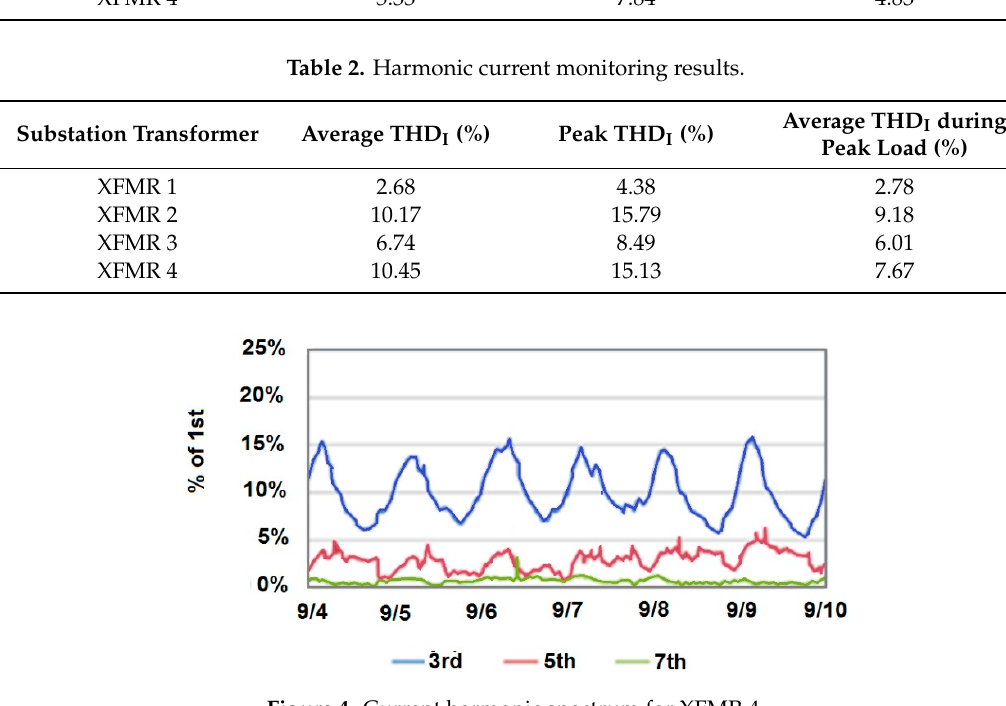
Table 2. Harmonic current monitoring results.